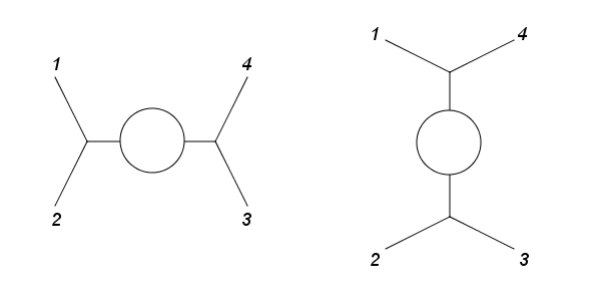
Figure 5 . m 1 (cid:0) loop